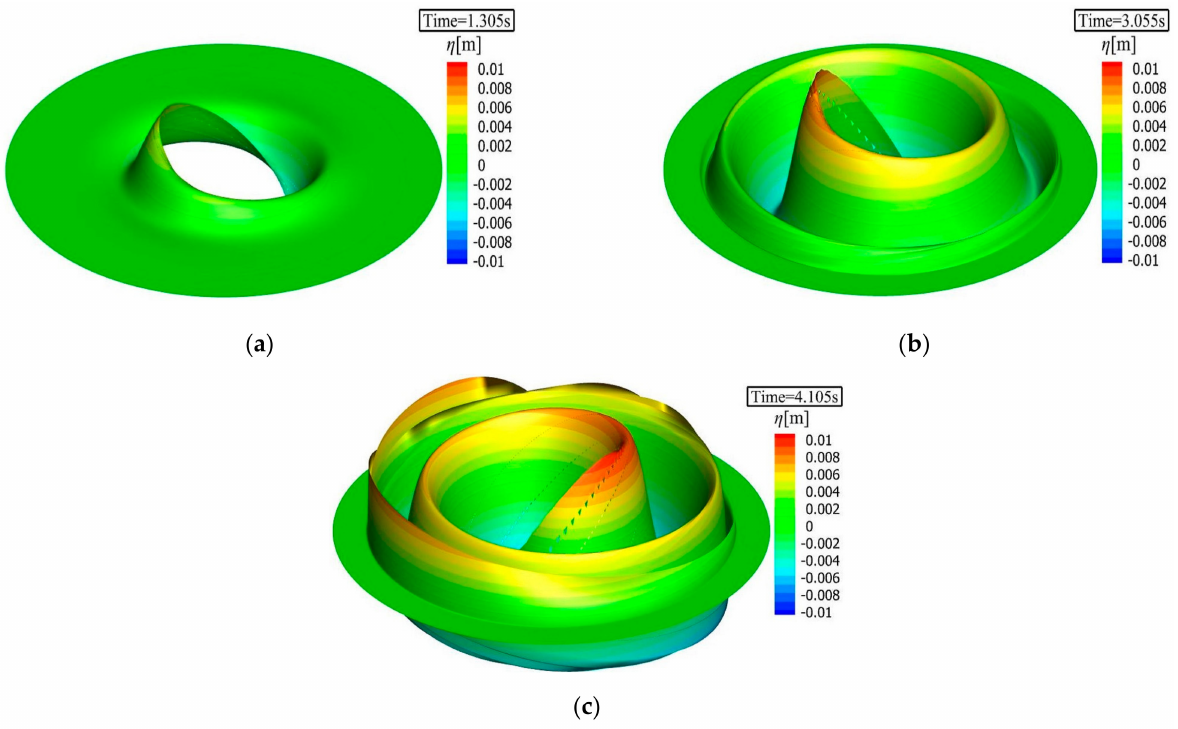
Figure 5. Spiral wave generation snapshots at different times: ( a ) 1.305 s, ( b ) 3.055 s, and ( c ) 4.105 s (wave period 2.0